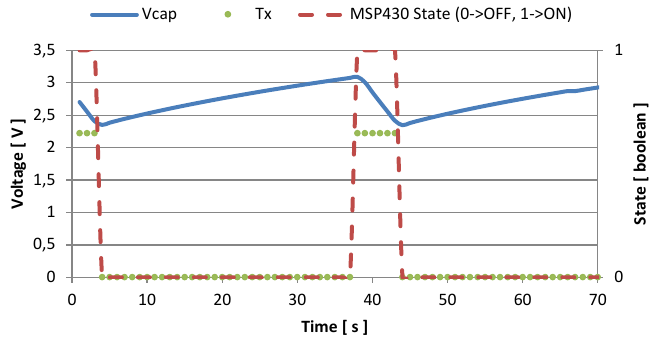
Figure 9. Voltage in the storage capacitance and transmission events with f CPU load = 50%.